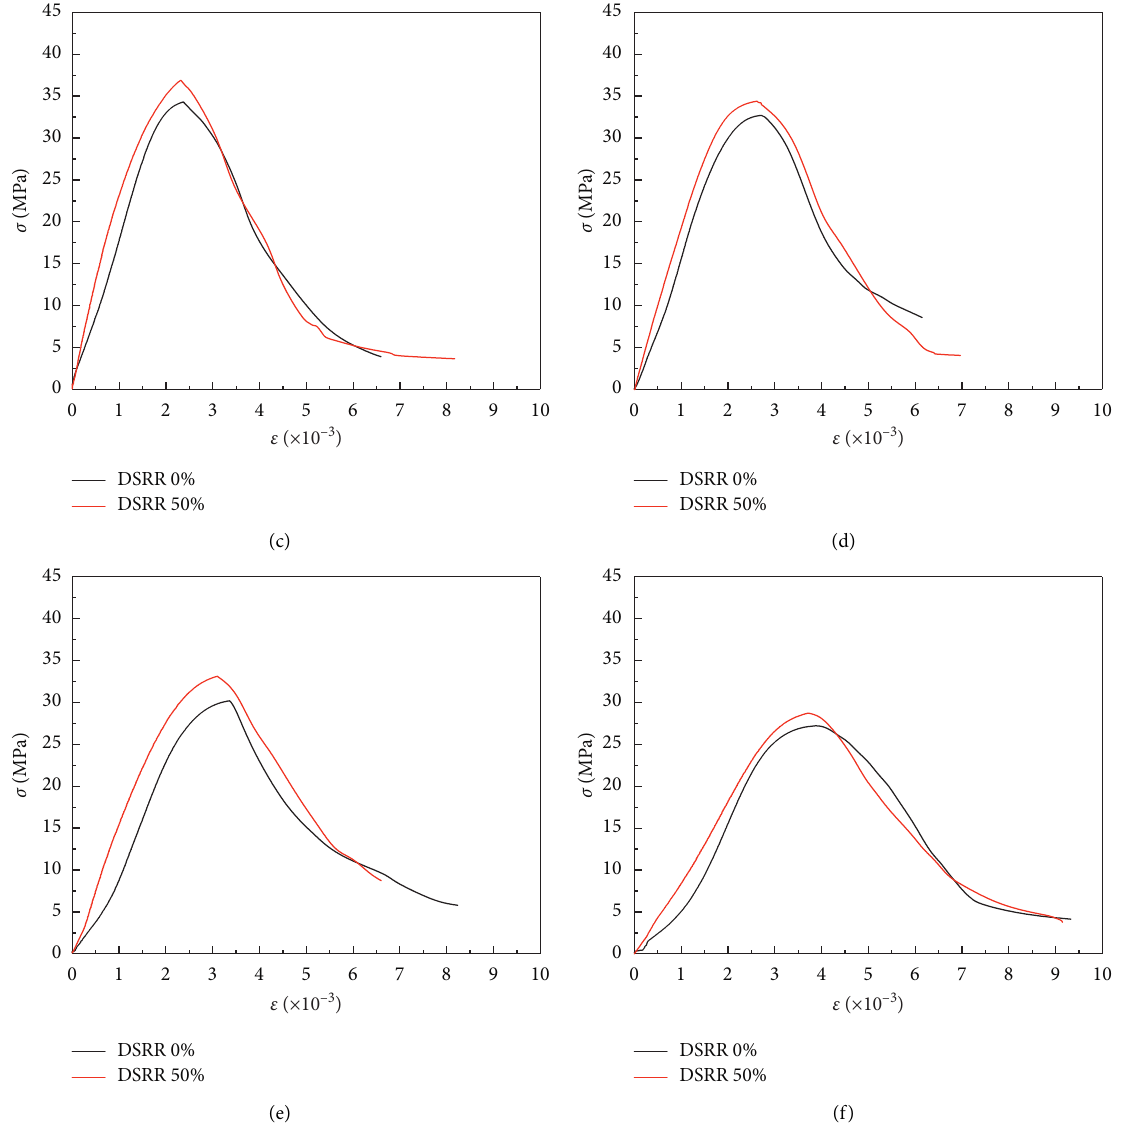
Figure 18: Comparison of stress-strain curves under different freeze-thaw cycles. (a) 0 times. (b) 25 times. (c) 50 times. (d) 75 times. (e) 100 times. (f) 125